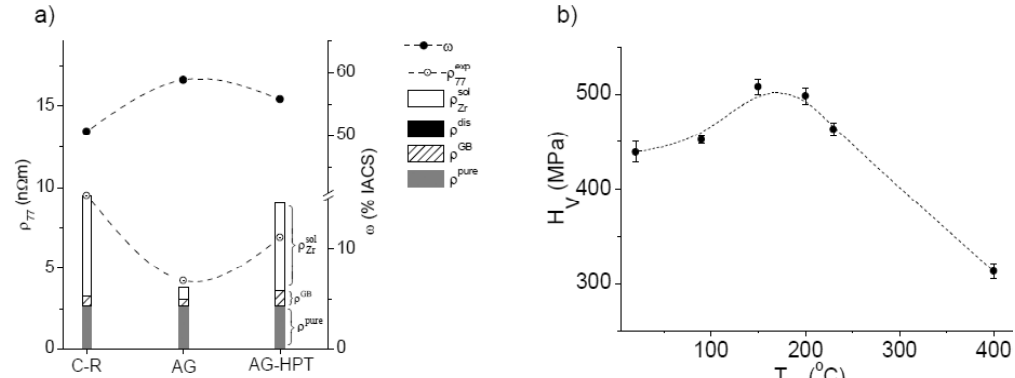
Fig. 6. a – experimentally obtained values of electrical conductivity (  ) at RT and electrical resistivity at 77K ( exp  ) for Al–0.4Zr(wt.%) alloy in initial C–R state, after aging (AG–state), and subsequent HPT processing 77 (AG–HPT state) in comparison with theoretically estimated contribution to resistivity from grain boundaries (  GB ), dislocations (  dis ), solute Zr atoms ( sol  ) electrical resistivity of coarse-grained pure Al (  pure ); b – Zr microhardness ( H ) of AG–HPT samples versus annealing V